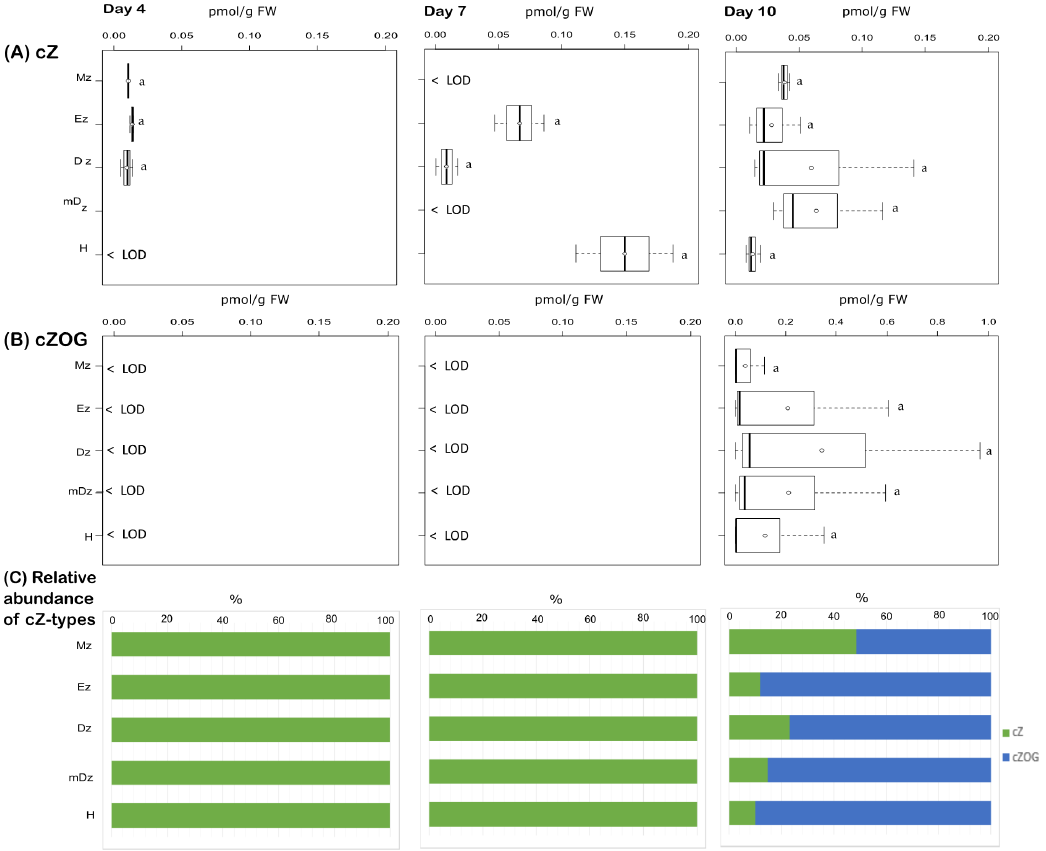
Figure 6. Quantification of cZ-type cytokinins in hypocotyl and developmental root sections of cacao seedlings. Levels of ( A ) cis-zeatin (cZ) and ( B ) cis-zeatin- O -glucoside (cZOG) were determined from the samples described in Figure 1. The levels of cis-zeatin riboside (cZR), cis-zeatin riboside- O -glucoside (cZROG), cis-zeatin riboside-5 ′ -monophosphate (cZR5’MP), cis-zeatin-7-glucoside (cZ7G), and cis-zeatin-9-glucoside (cZ9G) were below the limit of detection in all samples. The dark vertical line indicates median; boxes represent 25th and 75th percentiles; horizontal lines represent maximum and minimum values; circles indicate mean values. Significant variations in concentration determined by Welch’s test post hoc, p ≤ 0.05 among hypocotyl and primary root sections are indicated by letters, n = 3 independent biological replicates; FW = fresh weight. ( C ) Percent proportion of each cZ-type cytokinin metabolite.